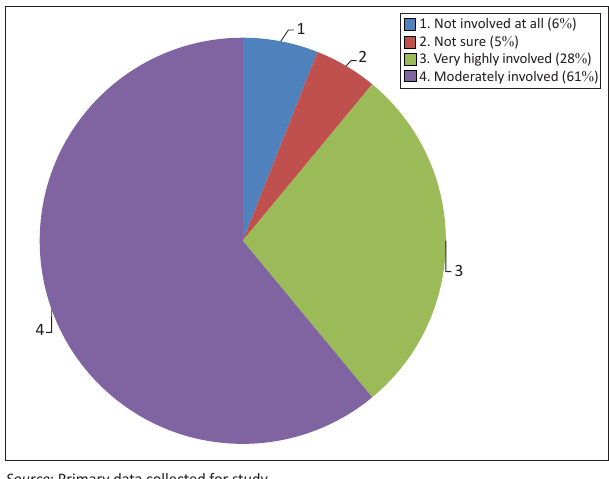
FIGURE 8: Extent of involvement in disaster